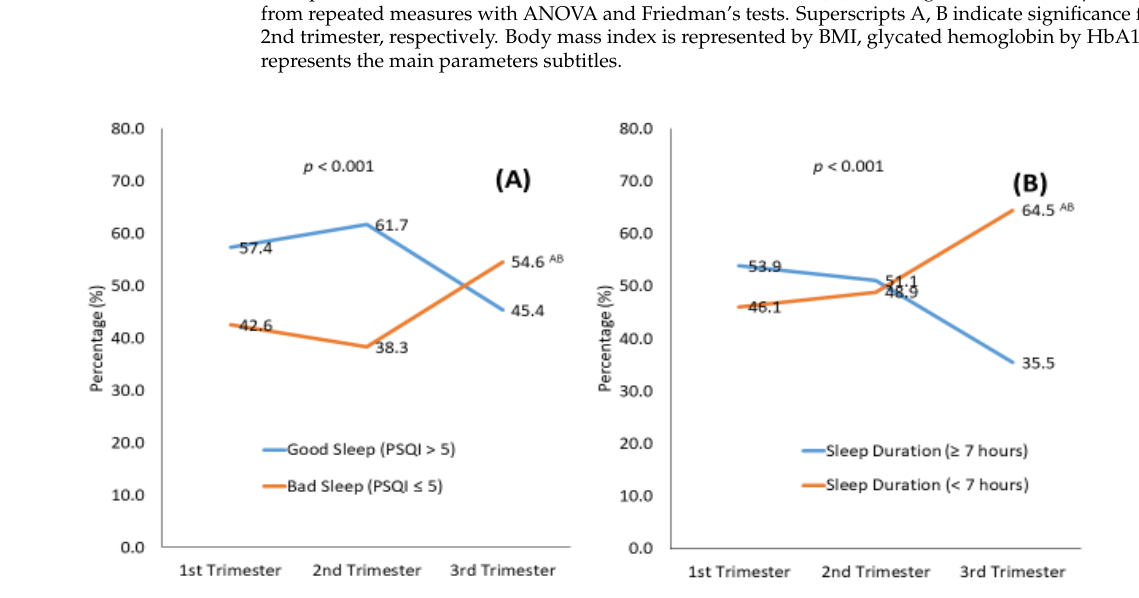
Figure 2. Pittsburgh Sleep Quality Index (PSQI) and score ( A ) and sleep duration ( B ) over the course of pregnancy. A PSQI score of 5 or less indicated poor sleep, and sleep duration less than 7 h indicated a short sleep duration. Superscripts A, B indicate significance from the 1st, 2nd trimester, respectively and AB from both.